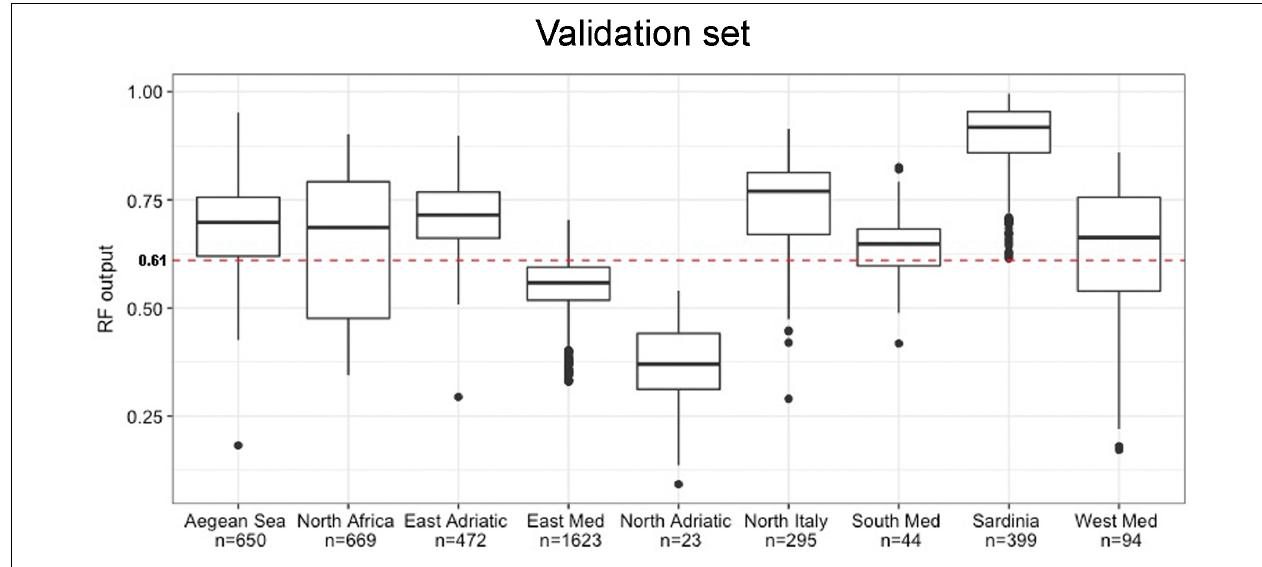
FIGURE 6 | Distribution of the RF output values for the validation set, i.e., for the Mediterranean areas where only presence records were available. The red dashed line represents the optimal cut-off ( t =